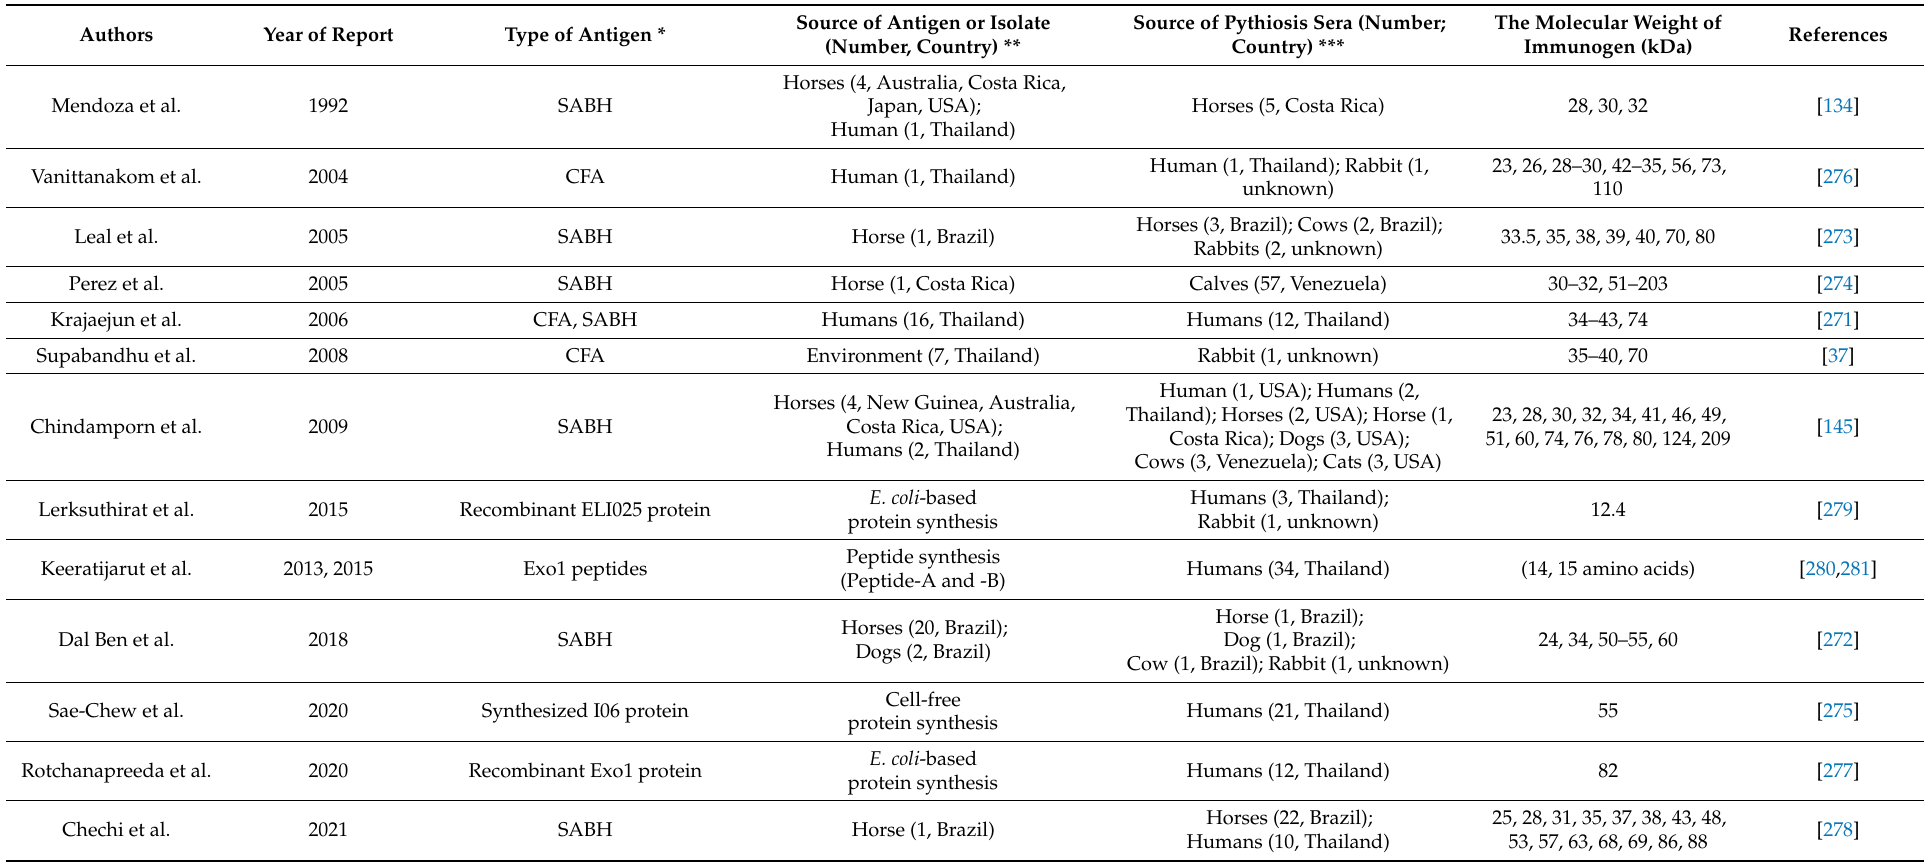
Table 6. Immunodominant antigens identified in P. insidiosum by Western blot